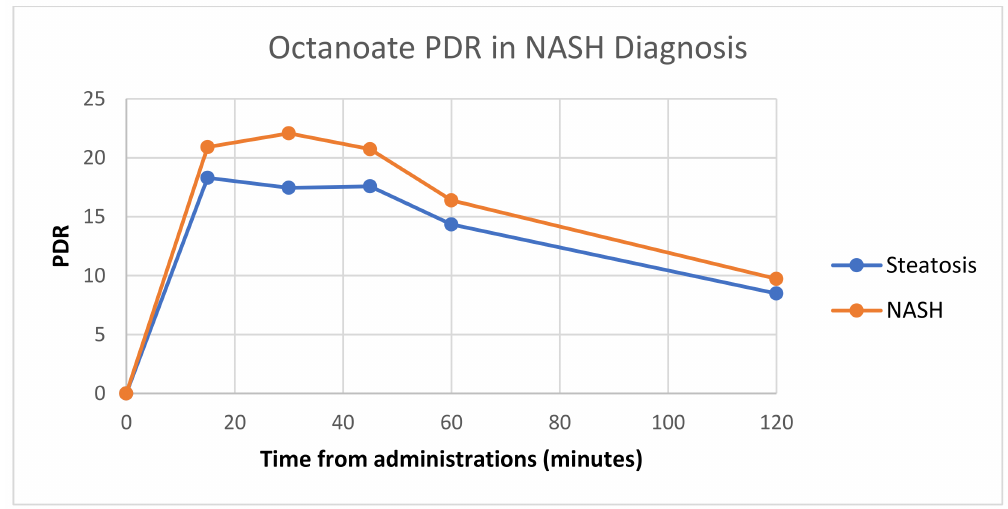
Figure 1. Comparison of PDR in steatosis vs. NASH for octanoate administration.